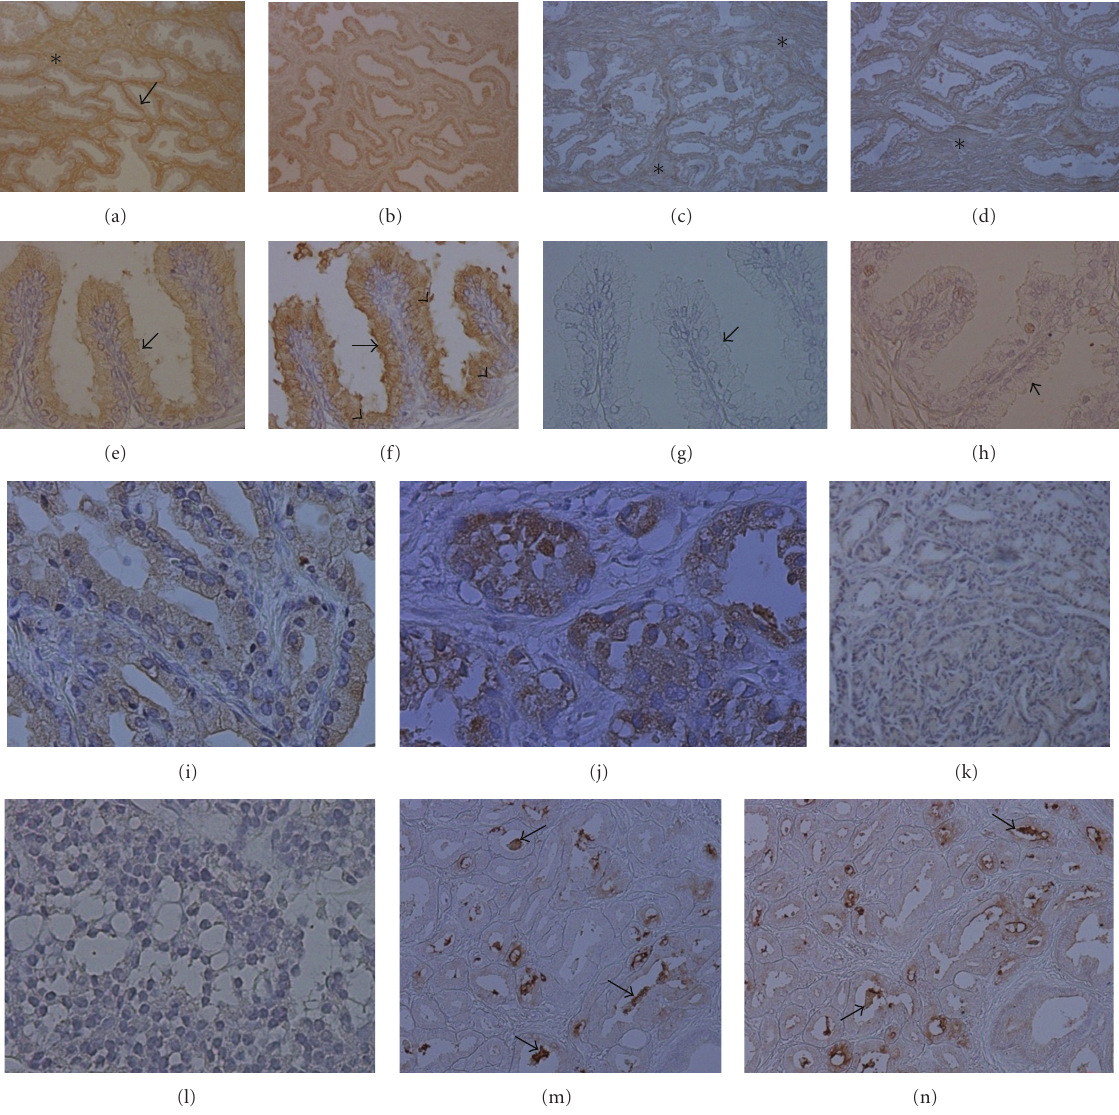
Figure 2: Histochemistry of prostatic tissues using Con A, Cramoll 1,4, PNA, and Cramoll 3. (a) Normal prostate stained with Con-A. Epithelial cells ( arrow ) present a weak staining while stroma ( asterisk ) is intensely stained. (b) Moderate staining by Cramoll 1,4 in epithelium of normal glands. (c and d) Normal prostate epithelium and stroma ( asterisks ) presenting weak staining by PNA and Cramoll 3, respectively. (e) Con A moderate staining of BPH glands ( arrow ). (f) BPH epithelial cells showing intense staining by Cramoll 1,4 in apical cytoplasm ( arrowheads ) and membrane ( arrow ). (g and h) BPH glands ( arrows ) were not stained or only weakly stained by PNA and Cramoll 3, respectively. (i and j) Gleason score 2 and 3 PCa cells stained with a moderate pattern, respectively. (k) Weak staining in Gleason score 4 PCa cells. (l) Nonstaining cells in Gleason score 5 PCa. (m and n) PCa gland lumens ( arrows ) presented an intense staining pattern for PNA and Cramoll 3, respectively. Magnification (a, b, c, d, k, m, and n) x100 and (e, f, g, h, i, j, and l)